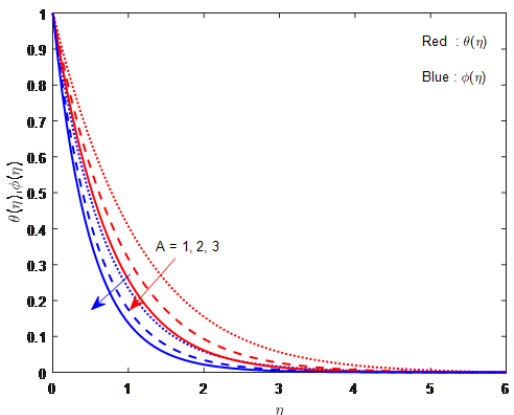
Figure 9: Temperature and concentration profiles for different val- ues of radiation parameter R